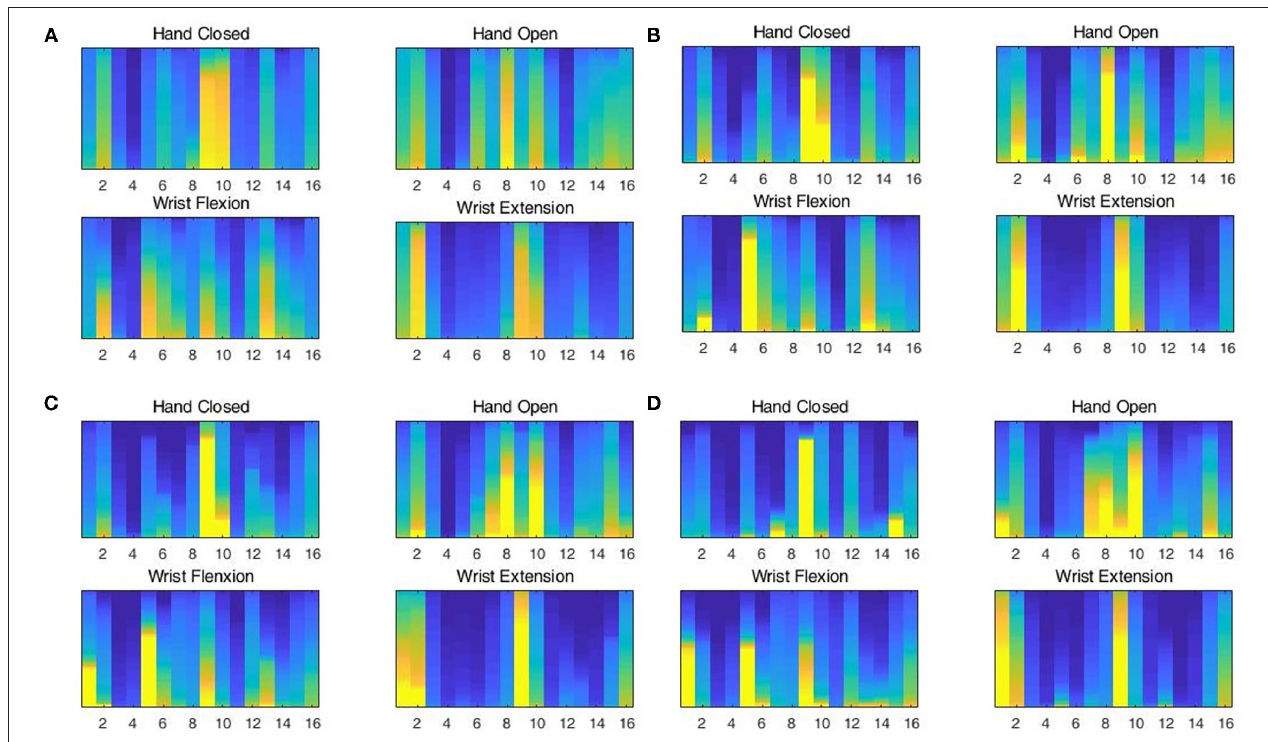
FIGURE 8 | Changes in channel weights at different stages of (A) the existing samples, (B) the initial train set, (C) the updated train set, and (D) test